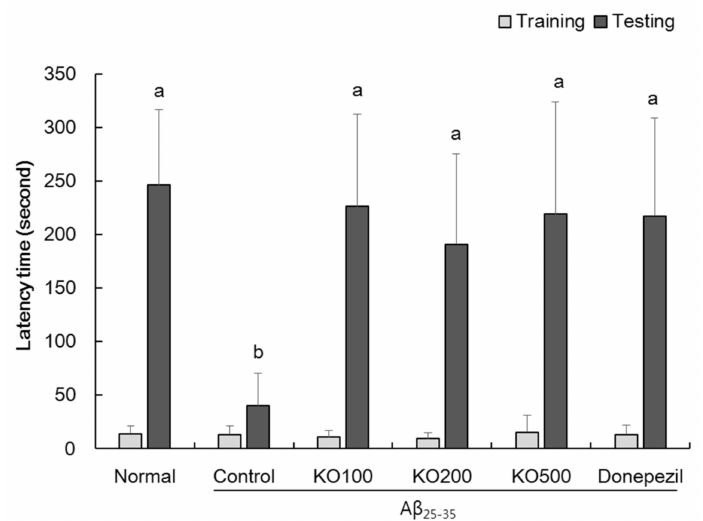
Figure 3. E ff ects of krill oil (KO) on passive avoidance ability in the passive avoidance test. Normal, injection of saline solution + oral administration of water; Control, injection of A β 25–35 + oral administration of water; KO100, injection of A β 25–35 + oral administration of KO at 100 mg / kg / day; KO200, injection of A β 25–35 + oral administration of KO at 200 mg / kg / day; KO500, injection of A β 25–35 + oral administration of KO at 500 mg / kg / day; Donepezil, injection of A β + oral administration of 25–35 donepezil at 5 mg / kg / day. Values are represented as means ± SD ( n = 8). a,b Means with the di ff erent letters are significantly di ff erent ( p < 0.05) by Duncan’s multiple range